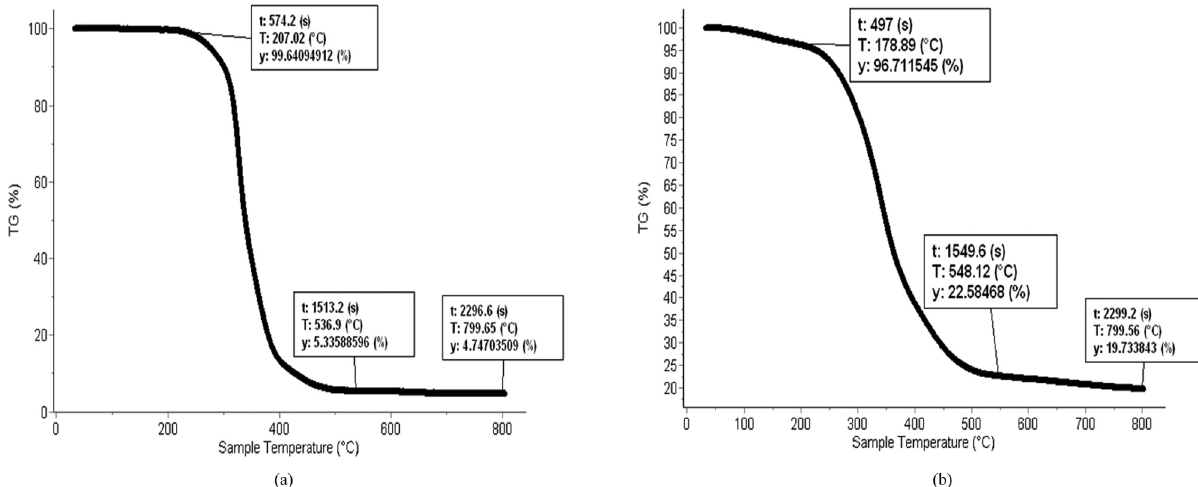
Figure 45: ( a ) TGA curve of the neat recycled EVA polymer without any leather fi bers; ( b ) TGA curve of the leather bu ffi ng dust/recycled EVA polymer